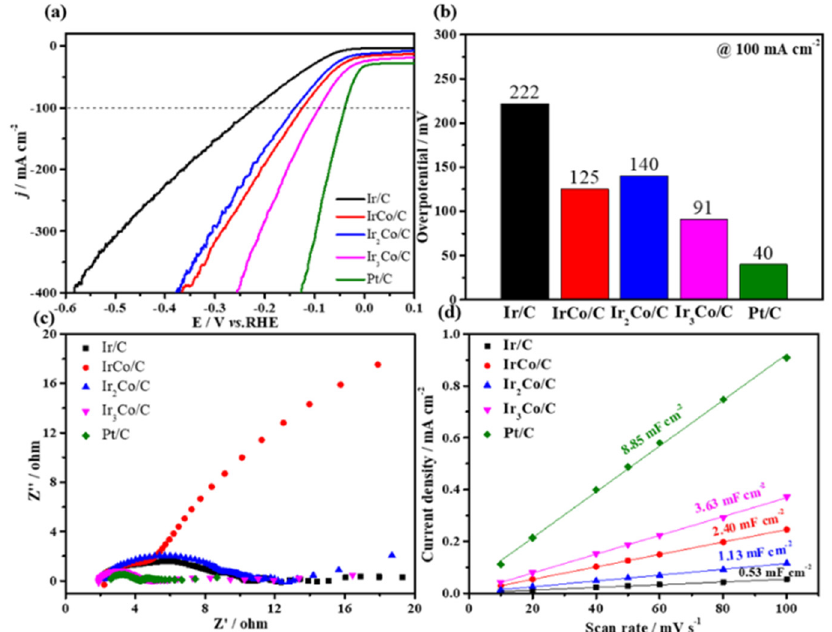
Figure 3. Electrochemical test results of different catalysts. ( a ) Polarization curves of HER in 0.5 M H 2 SO 4 . ( b ) The overpotential required to reach 100 mA cm − 2 . ( c ) EIS. ( d ) Electrical double-layer capacitor (C dl ).